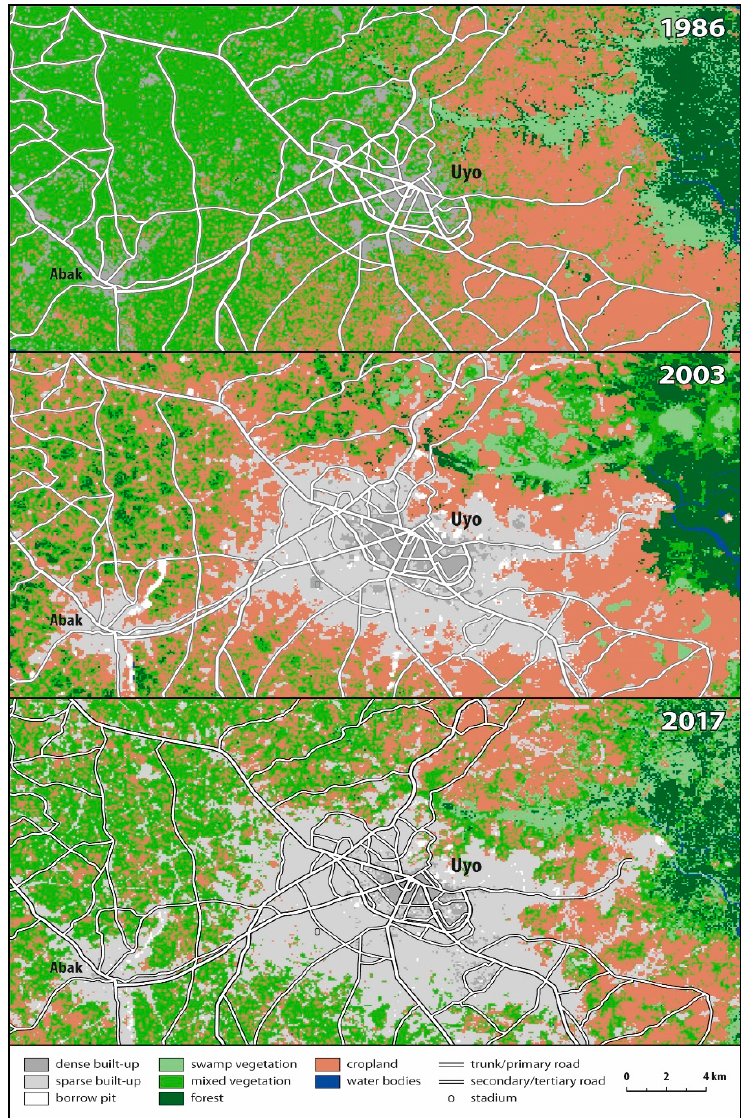
Figure 2. Land cover maps of Uyo for 1986, 2003, and 2017. Table 3. Land cover use statistics of Uyo from 1986 to 2017.